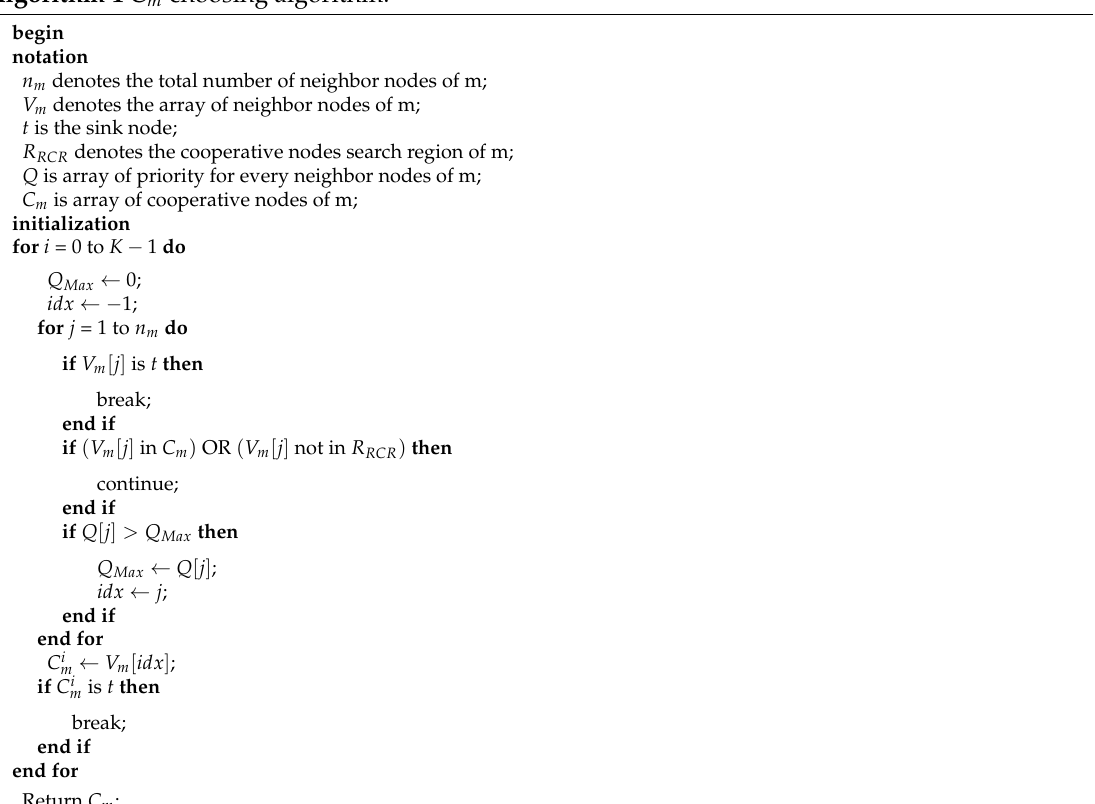
Algorithm 1 C m choosing